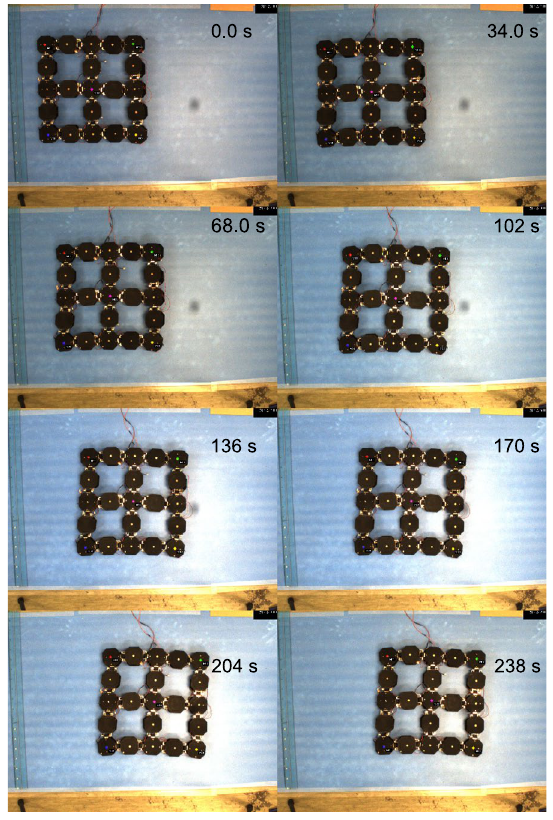
Fig. 21 Translational locomotion of WORMESH-II for IMF (wave parameters are A = 0.13 π , ω = π/ 20 , and β = 3 π/ 2